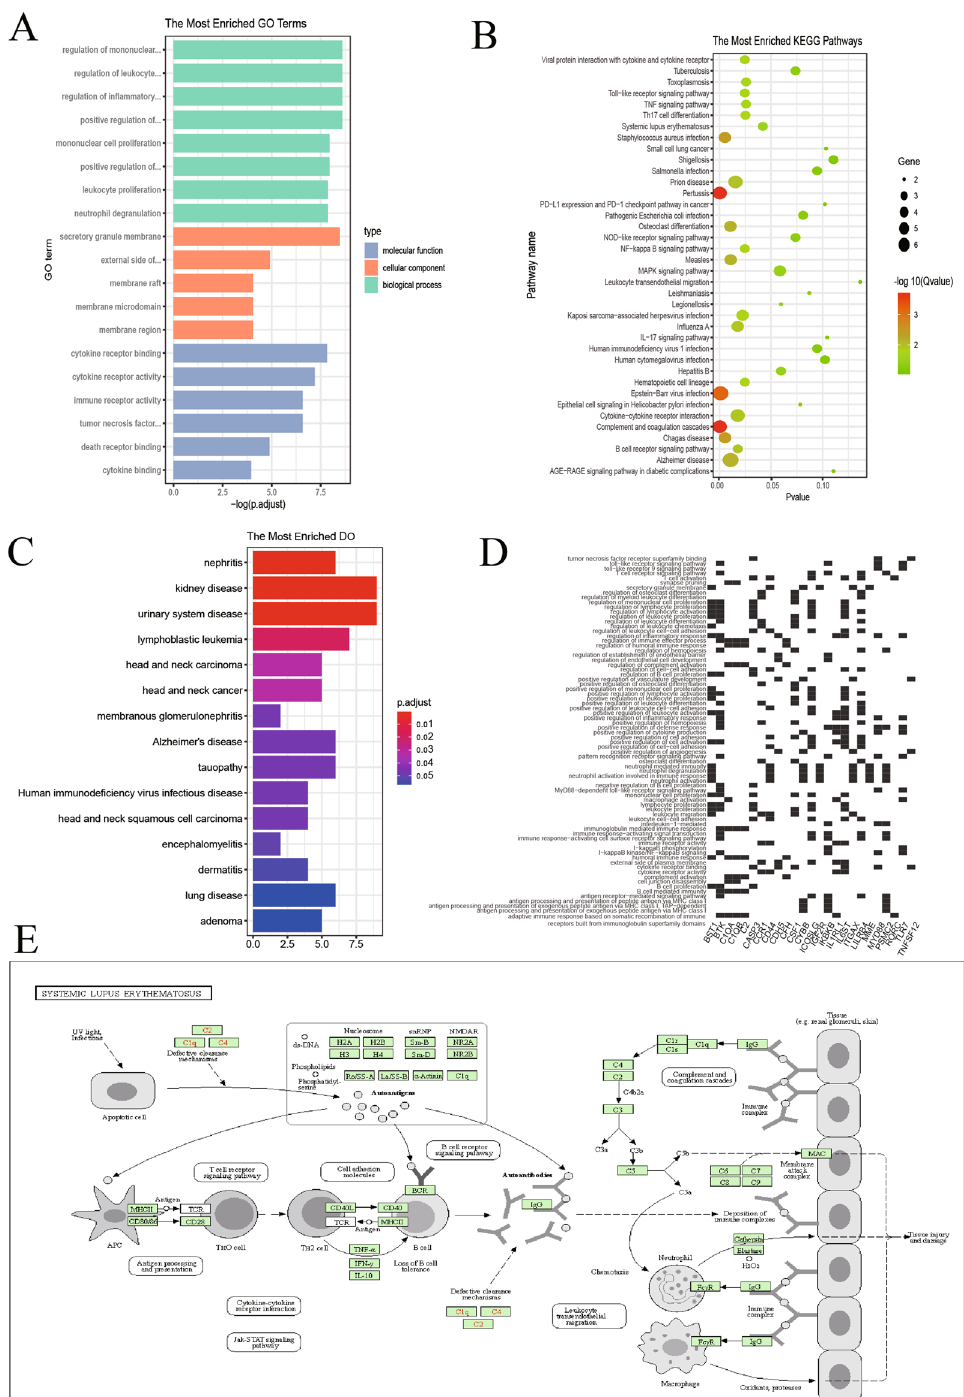
Figure 4. GO functional enrichment analysis, KEGG pathway enrichment analysis, and DO enrichment analysis. Three ways of enrichment analyses were performed upon the 26 co-DEGs. ( A ) GO analysis. The adjust p-value was calculated as x-axis and the GO terms was denoted as y-axis. Blue-purple strip, orange strip and range strip represented molecular function, cellular components and biological processes respectively. ( B ) The bubble diagram for the KEGG analysis results. Distinct size of dots represented the number of genes enriched in the corresponding pathway. ( C ) DO analysis. The x-axis represented 26 co-DEGs and the y-axis represented DO terms. ( D ) the co-DEGs in the enriched GO terms were particularly exhibited. ( E ) KEGG pathway associated with lupus